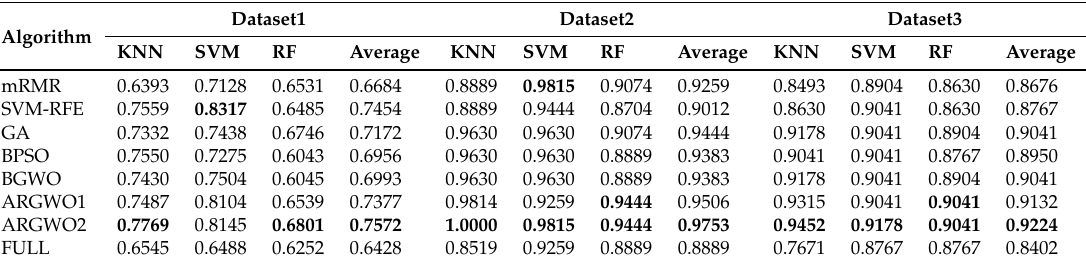
Table 6. Classification accuracy comparison of various methods in the test set.